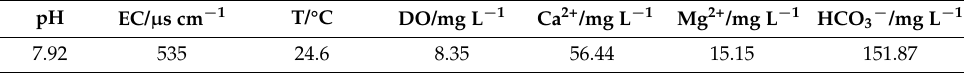
Table 2. Water quality parameters and main ionic composition at Yelang